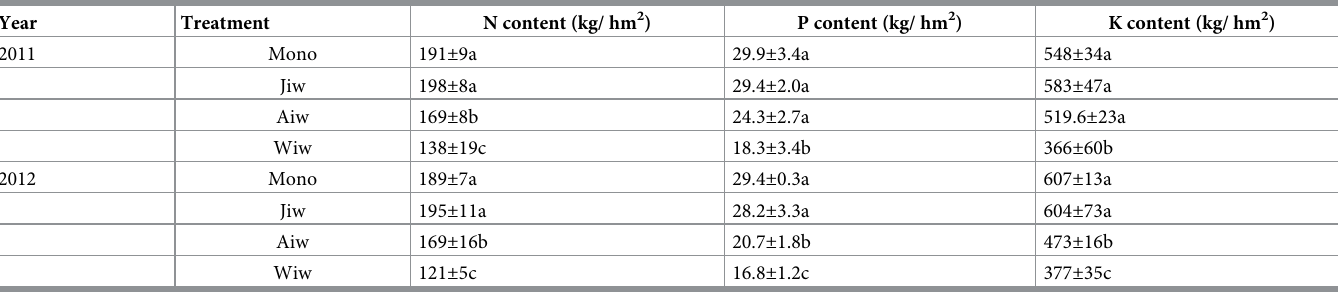
Table 3. The N, P and K contents of wheat in monoculture configurations and 3 different fruit tree-wheat intercropping systems in 2011 and 2012. Year